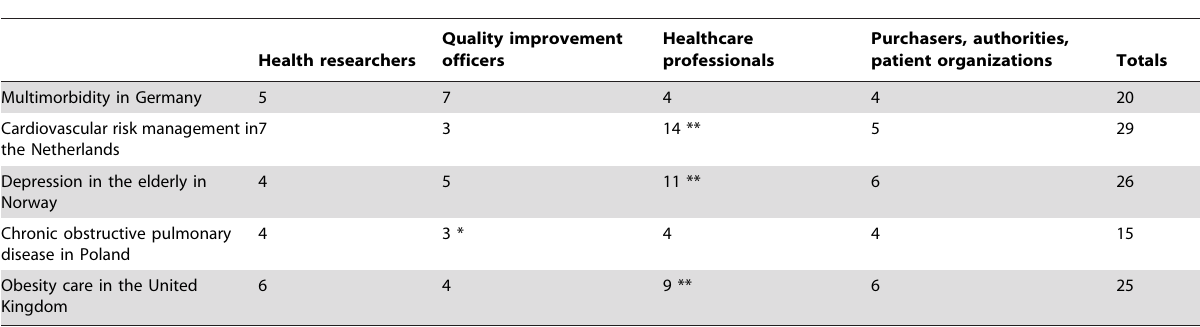
Table 2. Number of participants in the group interviews (n=115 individuals).